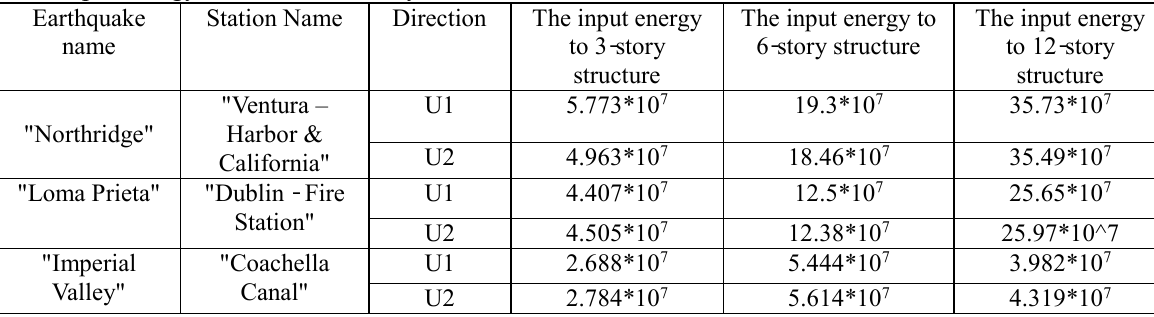
The input energy to 3, 6 and 12-story